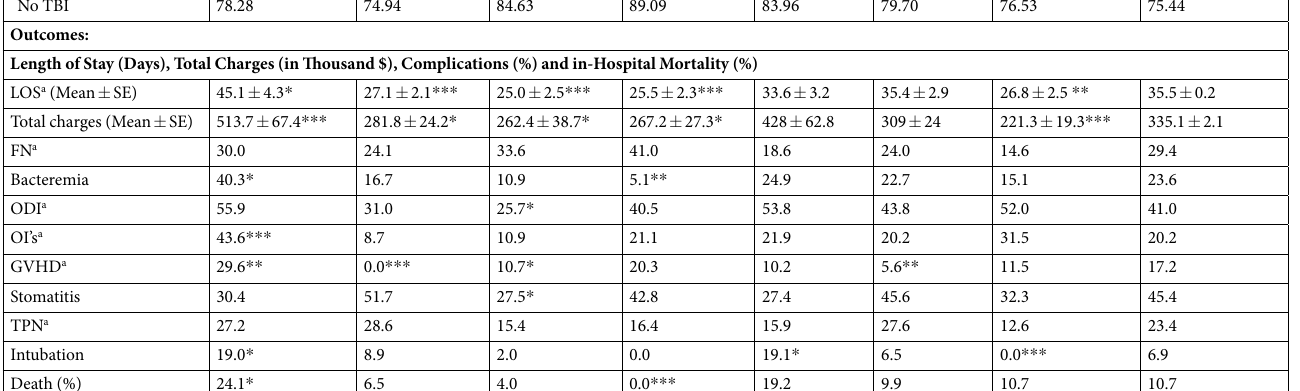
Table 2. Baseline characteristics and outcomes in patients undergoing Allogeneic HSCT from 1998 to 2011. a Abbreviations: IMID, Immune mediated Inflammatory disease; CCI, Charlson Co-morbidity Index; TBI, Total Body Irradiation; ODI, Other Documented Infections; OI’s, Opportunistic infections; GVHD, Graft-vs.-Host Disease, available after 2007; TPN, Total Parenteral Nutrition; LOS, Length of Stay; FN, Febrile Neutropenia; HSCT, Hematopoietic Stem Cell Transplantation; UC, Ulcerative Colitis; CD, Crohn’s Disease; RA, Rheumatoid Arthritis; DM, Diabetes Mellitus; SLE, Systemic Lupus Erythematosus; MS, Multiple Sclerosis For outcomes: * P ≤ 0.05 as compared to no IMIDs group; ** P ≤ 0.01 as compared to no IMIDs group; *** P ≤ 0.001